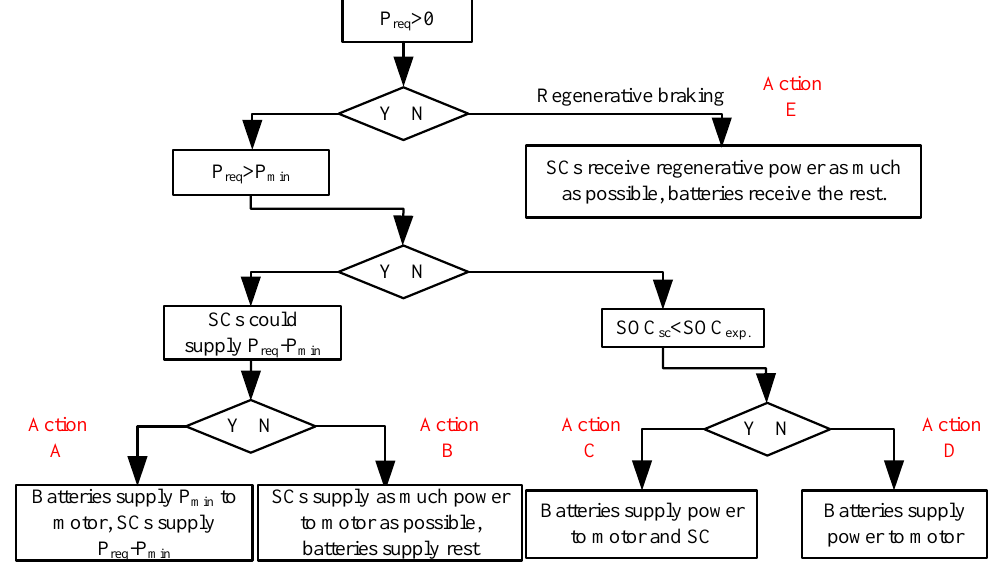
Figure 15. Control strategy diagram.